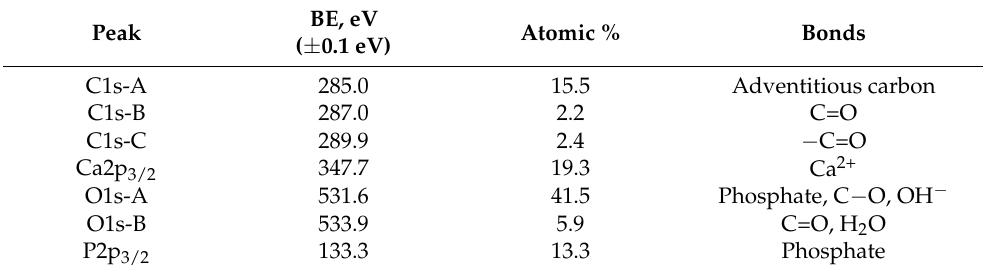
Figure 3. Survey spectrum of HA-FCC reference sample. The main peaks of P, Ca, C and O are indicated. Table 1. XPS quantitative chemical composition of HA-FCC reference sample.